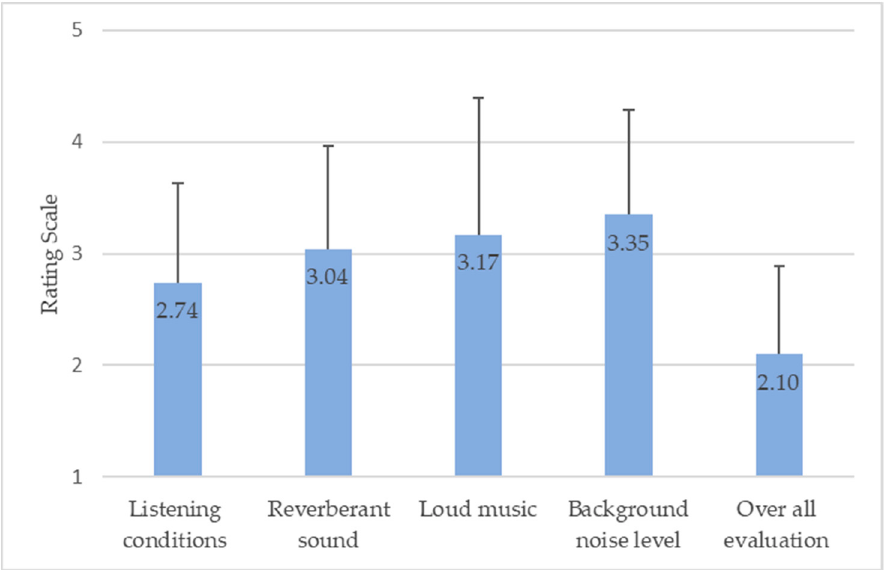
Figure 11. Results of questionnaire for all 401 subjects.